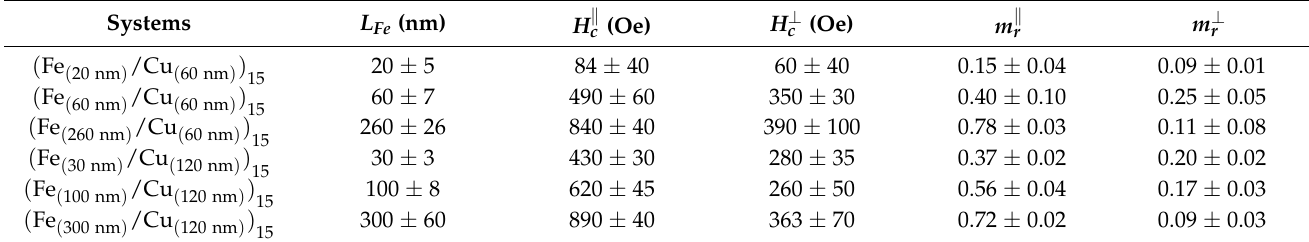
Table 1. Magnetic properties of multi-segmented NWs: Coercive field ( H c ) and normalized remanence ( m r ) measured with the magnetic field applied parallel ( (cid:107) ) and perpendicular ( ⊥ ) to the NWs’ longitudinal axis.